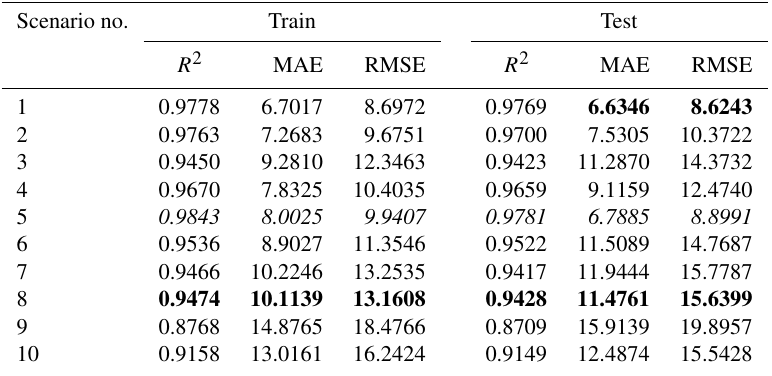
Table 6. Outcomes of the BFGS-ANN modelling approach for different scenarios based on R 2 , MAE, and RMSE (italic font represents the best results; bold represents the optimally selected model). Scenario no.